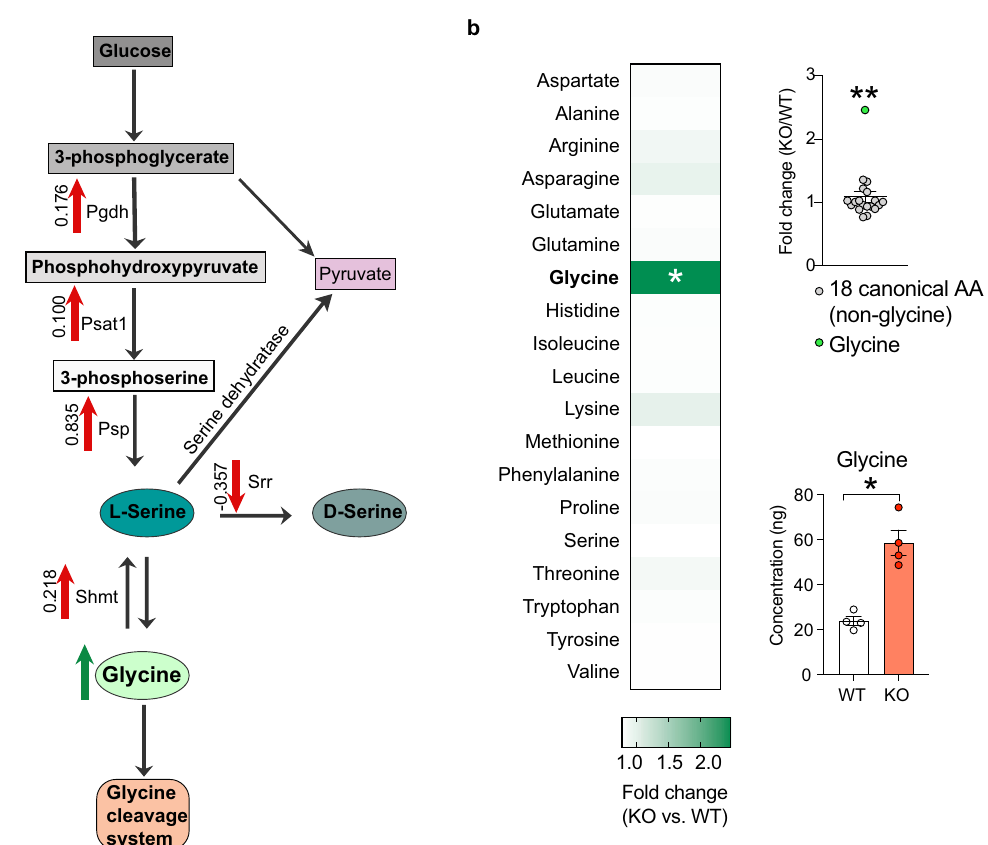
Fig. 3 Nsun2 ablation alters glycine – serine biosynthesis pathways leading to increased glycine amino acid concentrations in the mutant cortex. a Schematic of glycine – serine biosynthesis pathways that are signi fi cantly altered in cortex after Nsun2 ablation. Red arrows represent signi fi cant FDR adjusted P values <0.1 in unbiased proteomic screen (see Fig. 2b) between Nsun2 KO and WT cortex with average t test differences denoted next to arrows. The green arrow represents signi fi cantly changed amino acid concentration in KO vs. WT cortex. b Metabolomic pro fi ling of mutant and WT cortex for 19 amino acids (20 canonical amino acids, except for cysteine; see “ Methods ” ) revealed a signi fi cant increase in glycine for Nsun2 KO vs. WT ( n = 4/ genotype; two-tailed t tests, FDR adj. * P = 0.020; **Grubb ’ s test for fold changes identi fi ed glycine as a signi fi cant outlier with alpha = 0.001). Data are presented as mean values + / − SEM. Source data are available as a Source Data fi